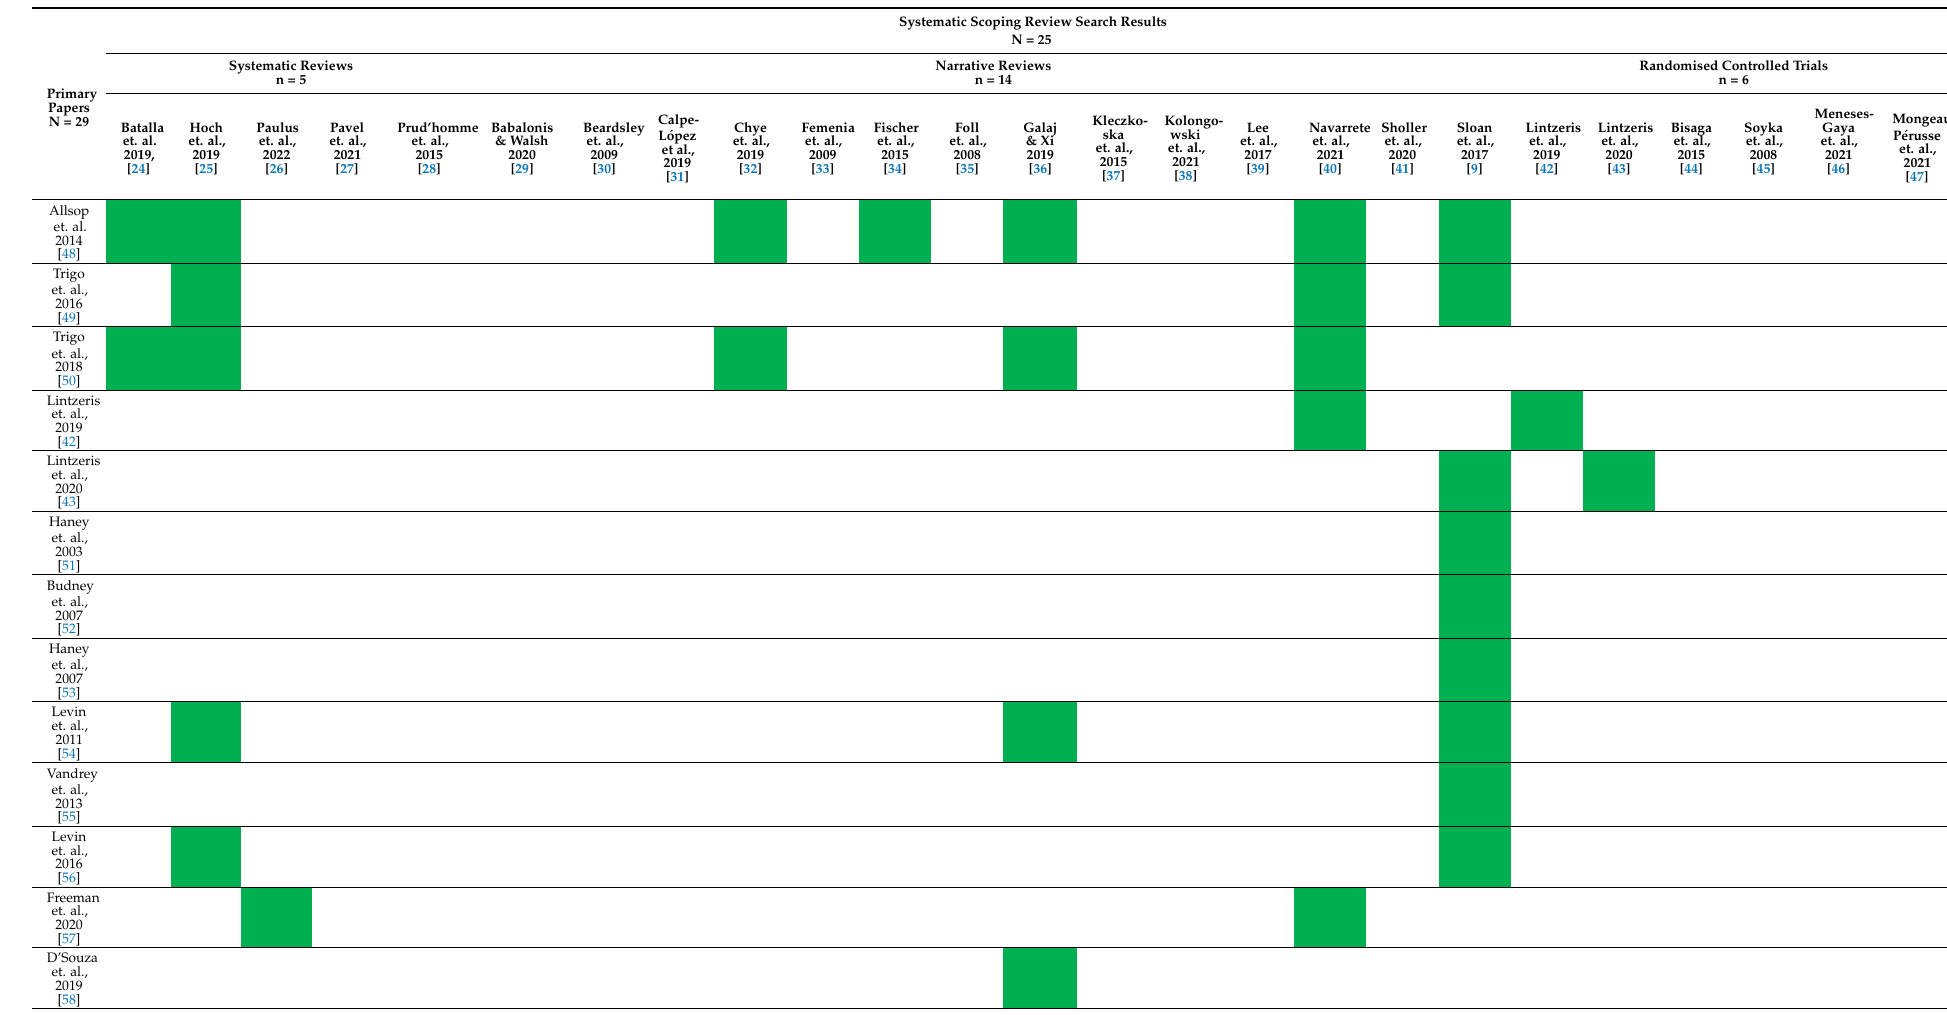
Table 2. Primary studies included in scoping